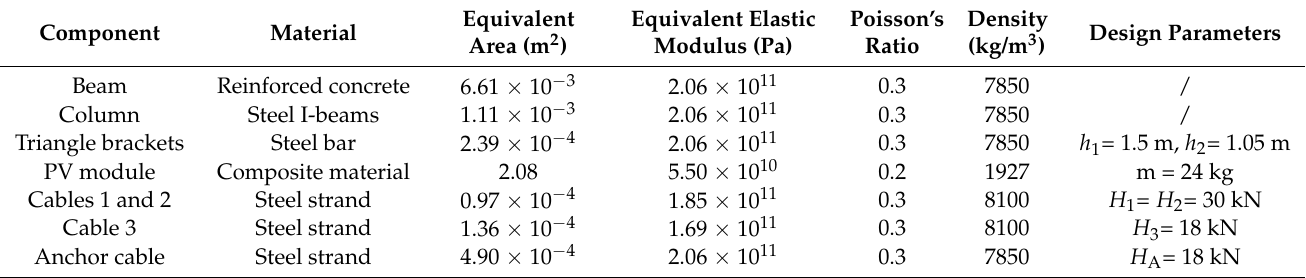
Table 2. Example of a new CSPS